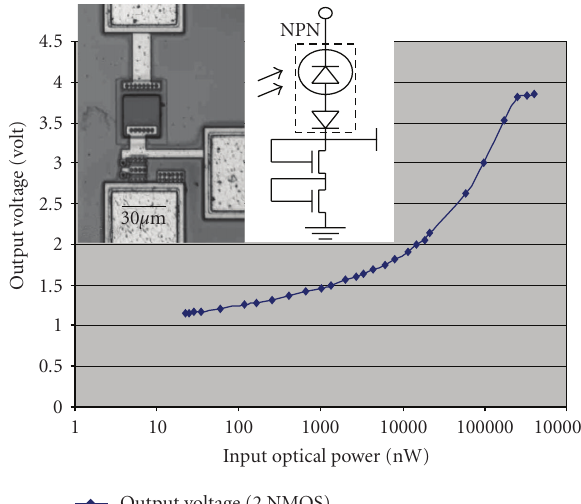
Figure 3: Output voltage of a single channel of saturated log- arithmic circuit as function of the input optical power (input wavelength: 830 nm). An optical micrograph of the single-channel logarithmic amplifier circuit and its correspondent schematic circuit diagram are